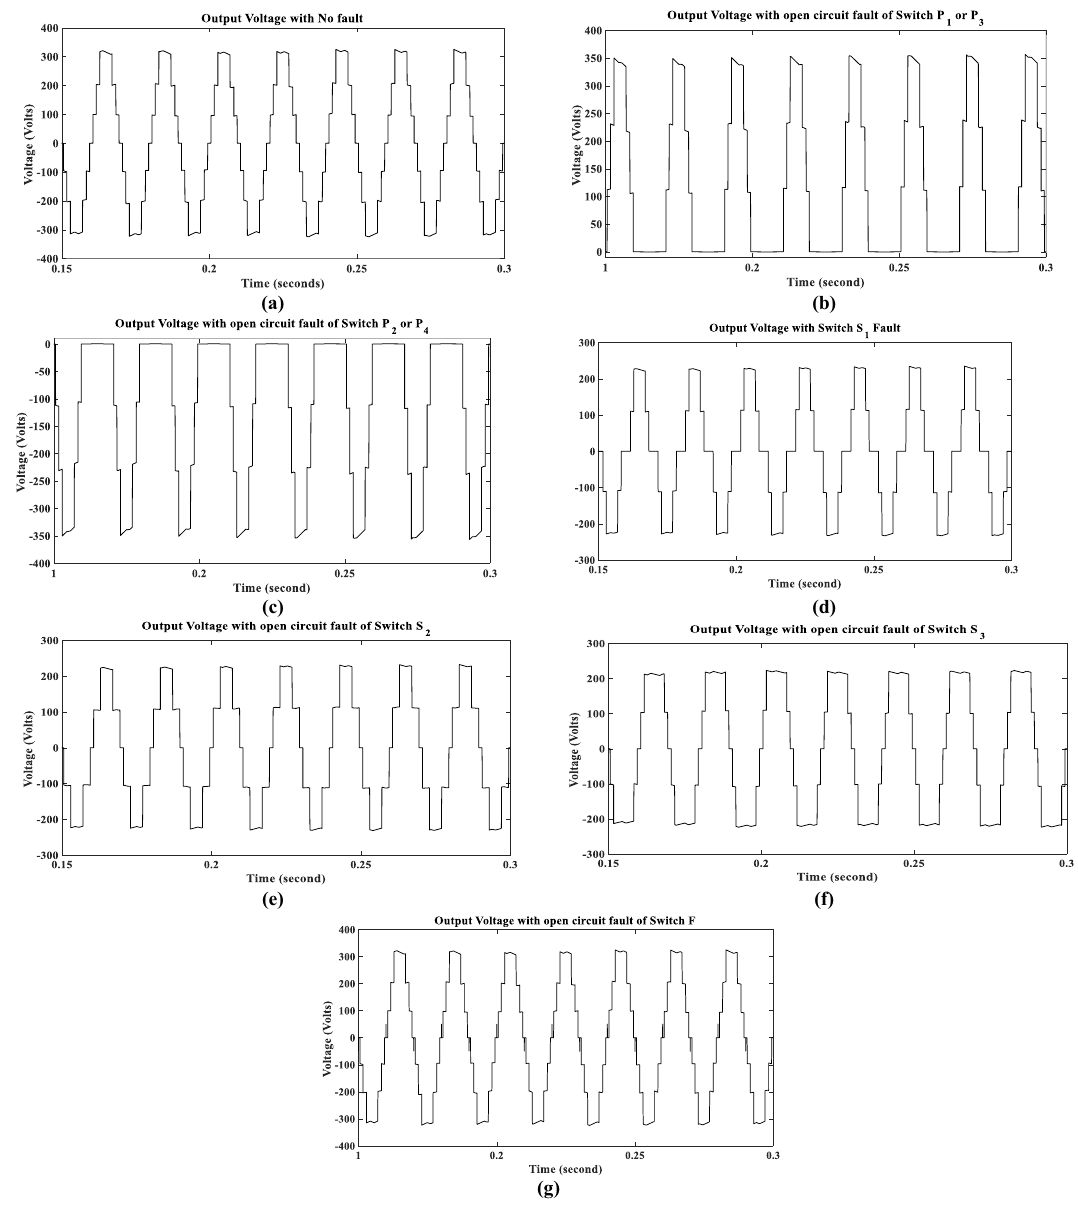
or P or both c Switch P 1 3